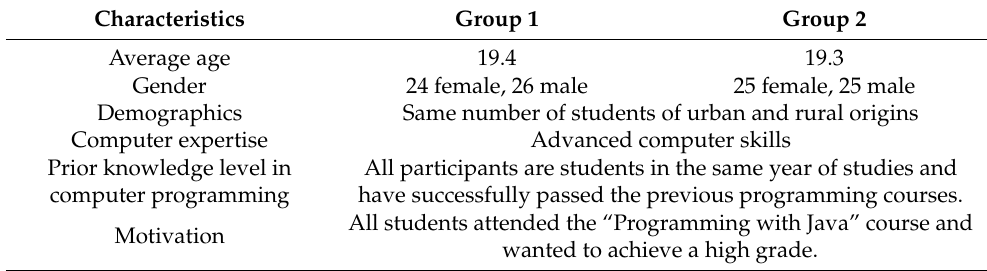
Table 2. Characteristics of the population.